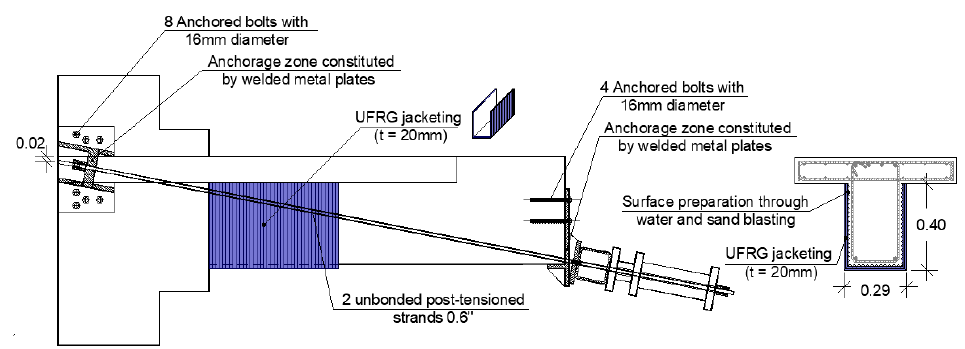
( e ) Figure 4. Execution of the UFRG jacketing. ( a ) Casting of the reinforced concrete beam; ( b ) Concrete surface prepared with water and sandblasting, and casting holes; ( c ) Application of the unidirec- tional and non-woven steel fibre mat; ( d ) Formwork setting for gravity casting with external vibra- tion; ( e ) Specimen final aspect.